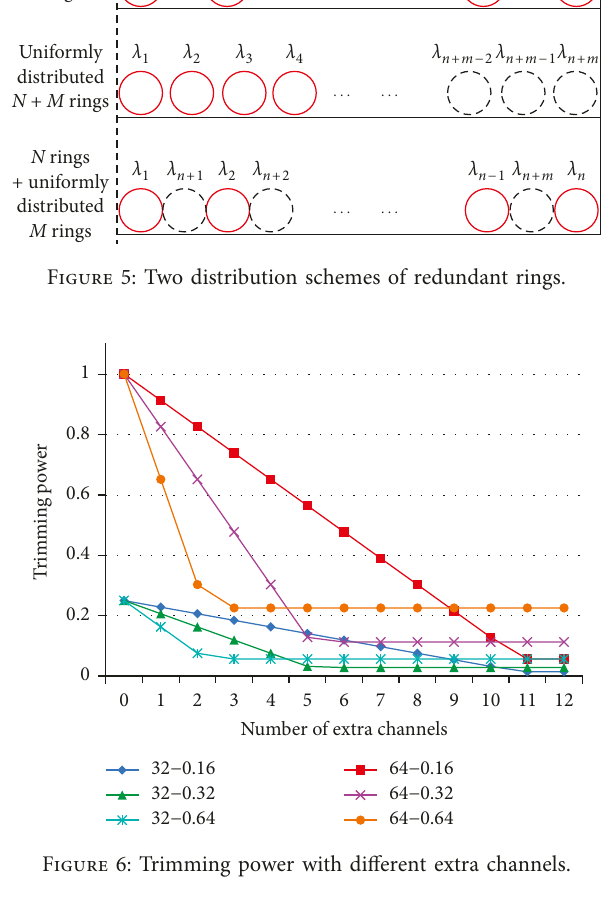
Figure 8: PV power with different redundant